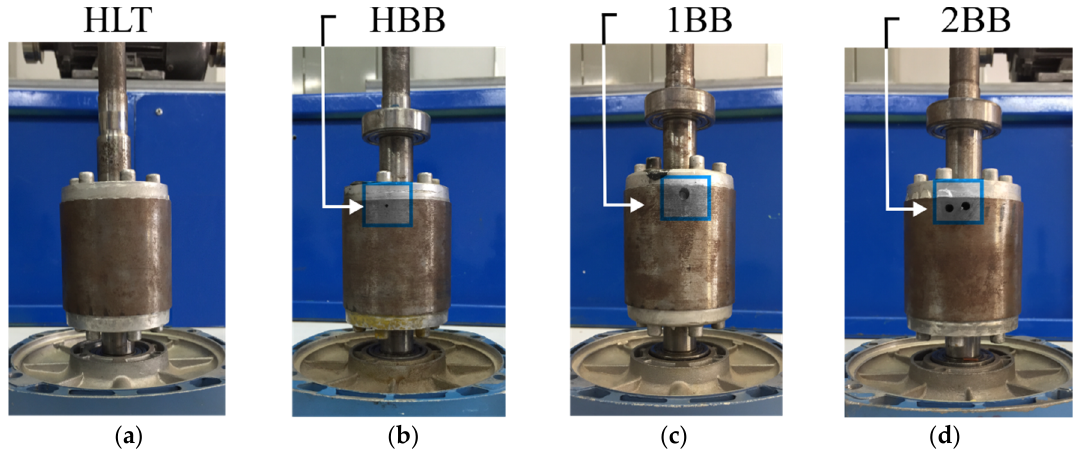
Figure 4. Rotor conditions: ( a ) HLT, ( b ) HBB, ( c ) 1BB, and ( d ) 2BB.